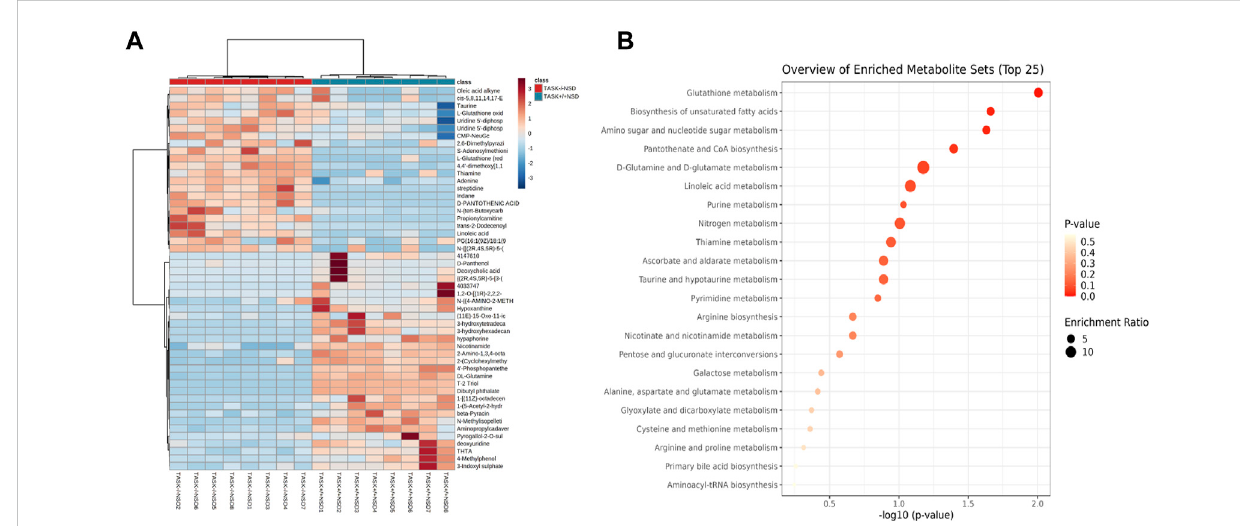
Enrichmentanalysisofsigni fi cantlychangedmetabolites.Heatmapvisualizationof51differentialmetabolitesbetweentheTASK +/+ andTASK − / − mice with a normal diet (A) . Comparing TASK − / − to TASK +/+ mice, 22 of their metabolites were upregulated, while 29 were downregulated (Wilcoxon rank-sum test, FDR-corrected p < 0.05). A heatmap was generated using Pearson ’ s chi-squared test for distance measurement and theWard testfor the clustering algorithm. Colors on the heatmap indicate expression levels (red means high; blue means low). (B) The bubble plot displays metabolic pathway enrichment analysis of signi fi cantly changed metabolites from (A) . The metabolic pathway was analyzed with MetaboAnalyst 5.0 using KEGG. A bubble ’ s size indicates its enrichment ratio. Colors indicate the signi fi cance of the annotated enrichment value based on a − log10 (adjusted p